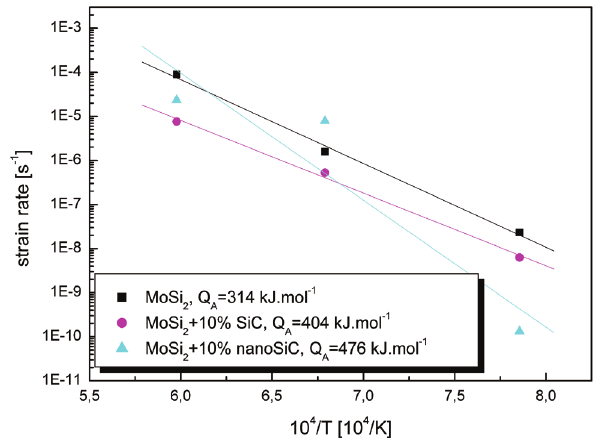
Fig. 3: Temperature dependence of the steady-state creep rates, four point bend creep